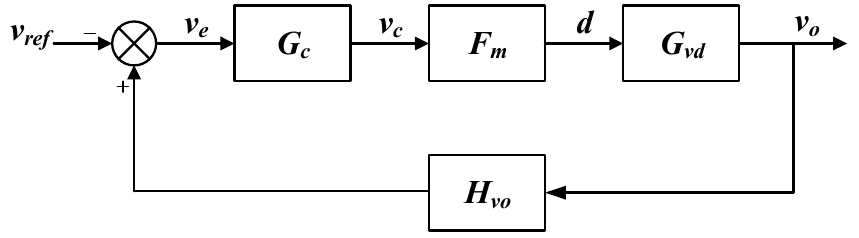
Figure 8. Block diagram of output voltage control. Table 1. System specifications and circuit parameters.